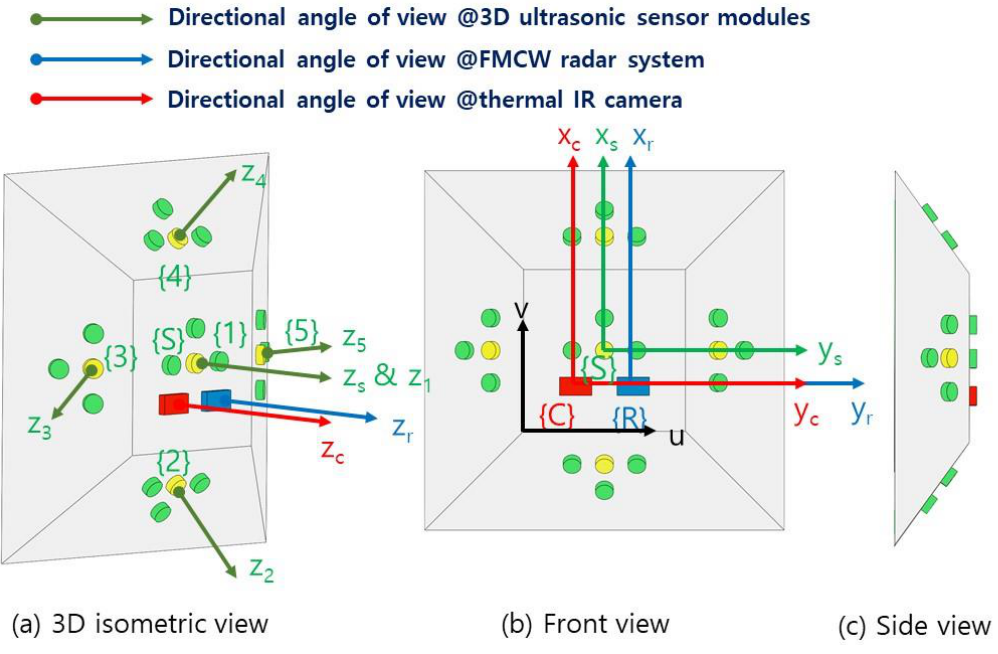
Figure 10. Concept of hardware implementation .